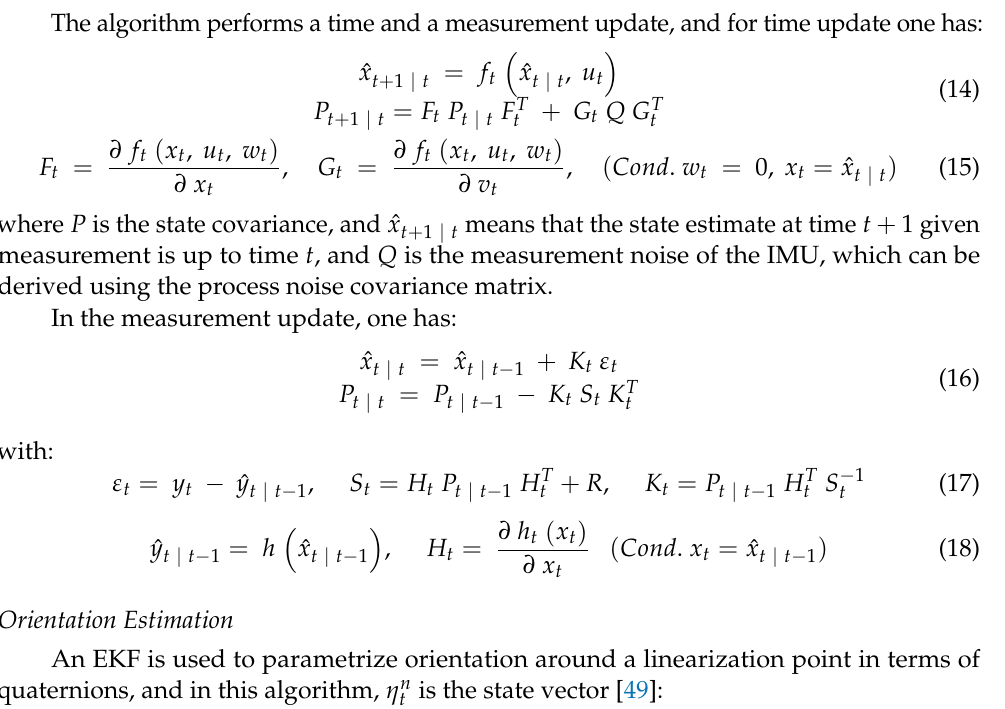
Figure 4. Block diagram of a dynamic system: u i is the control inputs, x i the internal state variable, and y i is the output, which is called observations or measurements.